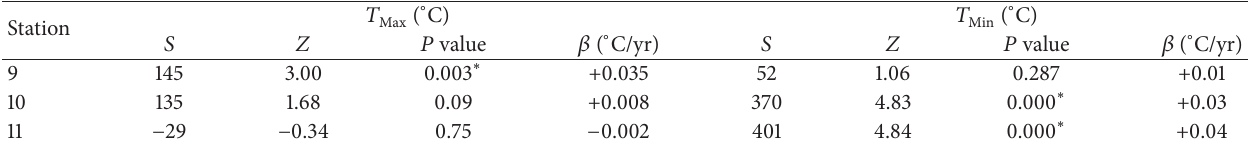
Table 6: Results of the MK and TSS methods for annual temperature variables in the Langat River Basin.